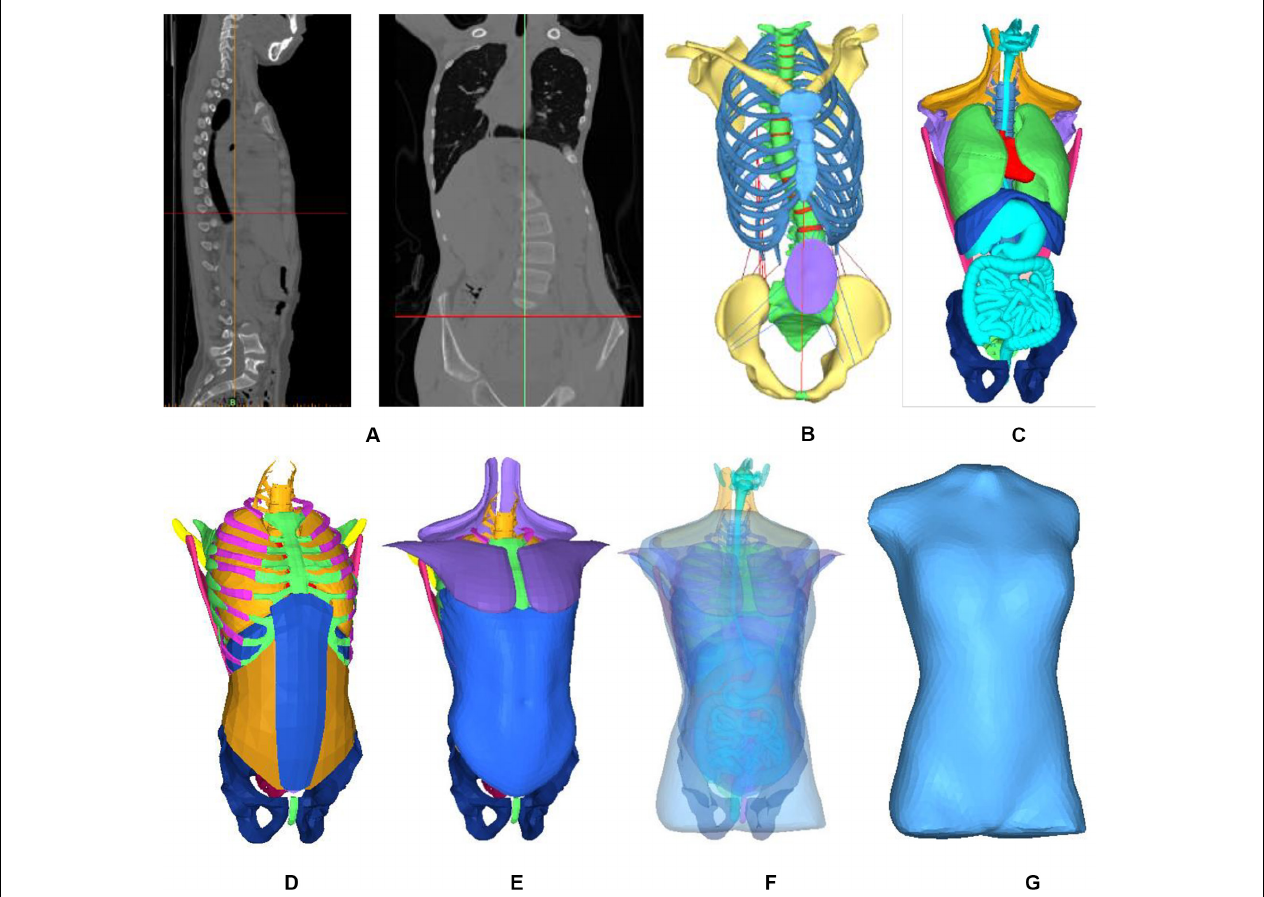
FIGURE 1 | Finite element model of patient trunk. (A) Constructing the internal structure of human body by using three-dimensional reconstruction technology of CT data. (B) Skeleton model, (C) Organ model, (D) Soft tissue, (E) Muscles, (F) All model, and (G) Finite element